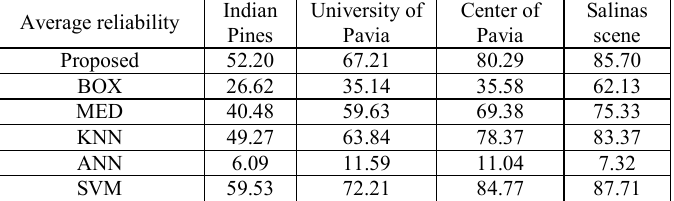
Table 2. Summary of comparison of reliability of classifiers for different